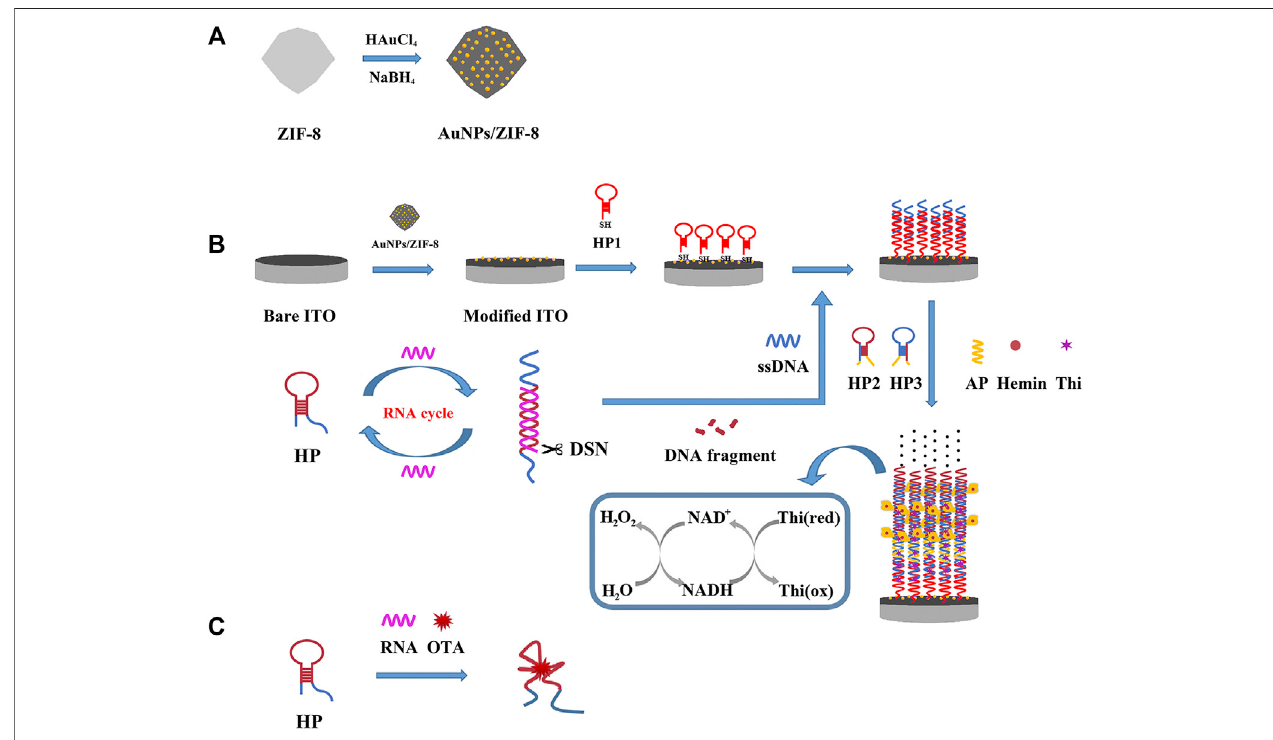
SCHEME 1 | Schematic illustration of the principle of the electrochemical aptasensor: (A) fabrication of the AuNPs/ZIF-8, (B) DSN-assisted signal ampli fi cation strategy in the absence of OTA, and (C) selective recognition of HP with OTA.